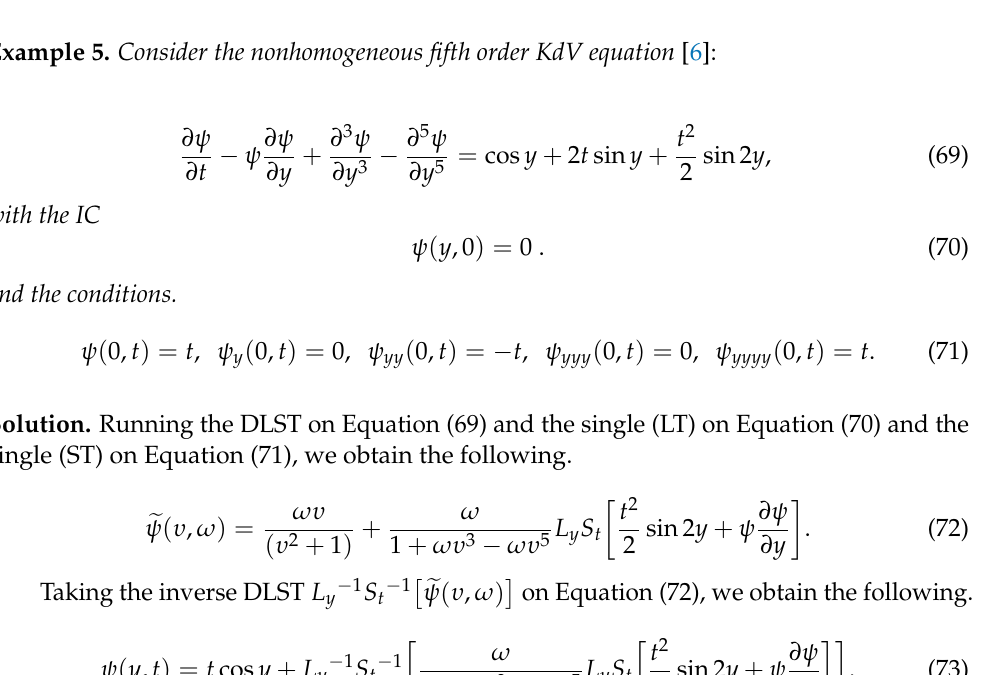
Figure 4. Exact solution ψ ( y , t ) of Example 4.